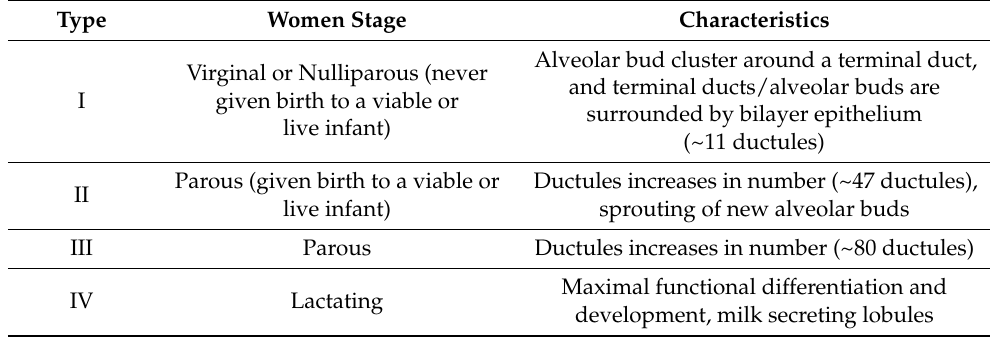
Table 3. Parity status of women mammary